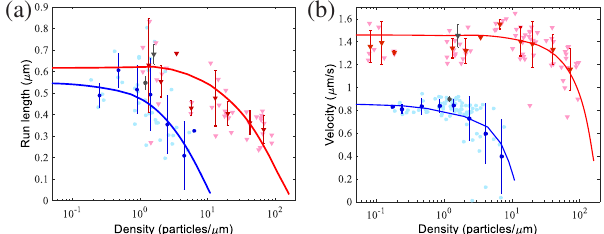
FIG. 4. Density-dependent run length and velocity: measure- ments and model predictions. (a) Run length as a function of density for kinesin-1 (blue dots) and OSM-3 (red triangles). Light dots show individual microtubule measurements, and dark symbols show averages and standard deviations over these measurements within density intervals of logarithmic size. Solid curves of the corresponding color show predictions of the extended TASEP-LK model (see main text). Single-particle measurements at low densities are shown in grey for comparison. (b) Velocity as a function of density. The plateau values of about 1 . 4 μ m = s for OSM-3 and about 0 . 8 μ m = s for kinesin-1 are in good agreement with single-particle tracking measurements in dilute motor assays [18,21 – 23]. Motility assays are performed in a PEM80 buffer. Numerical values of the experimental data used for fitting are listed in Table 3 of Ref. [17].